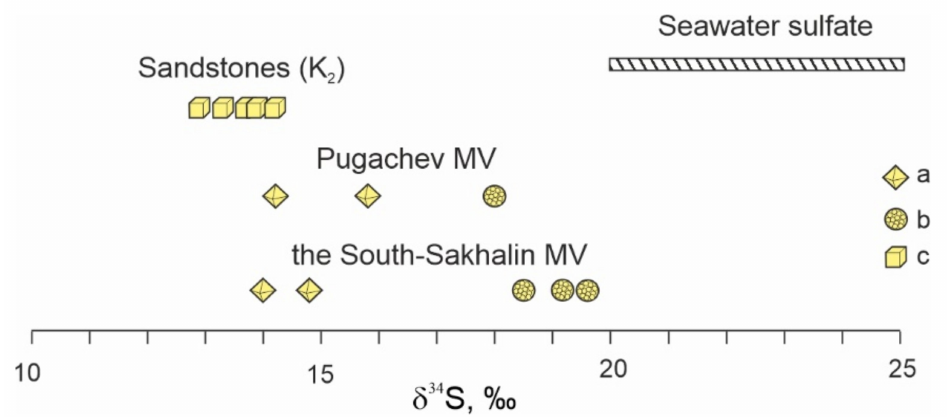
Figure 7. Sulfur isotope composition of pyrite crystals ( a ) and framboids ( b ) extracted from Sakhalin MVs and pyrite crystals from Upper Cretaceous sandstone ( c ). Sulfur isotope composition of seawater sulfate after